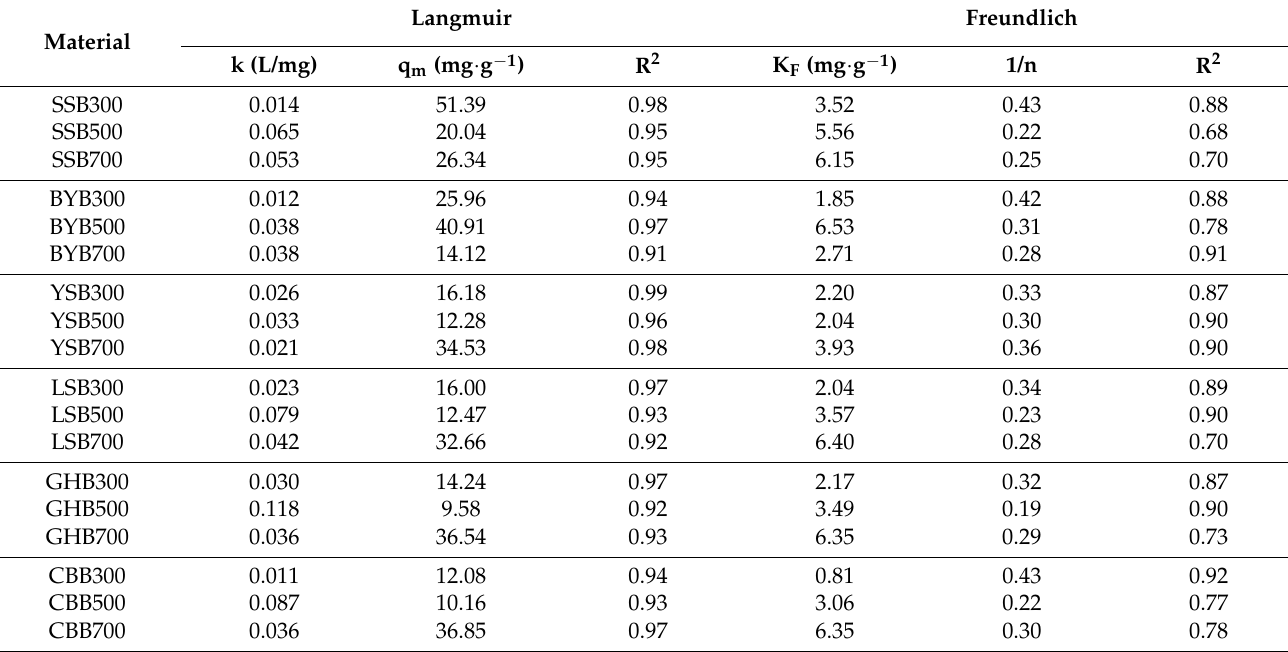
Table 1. Isotherm fitting results.